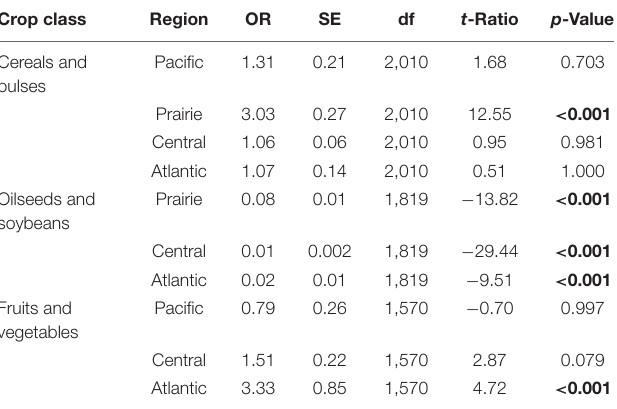
TABLE 3 | Estimated marginal means of pairwise comparisons between the earliest (1981) and latest (2016) years for the area in each crop class, for four regions in